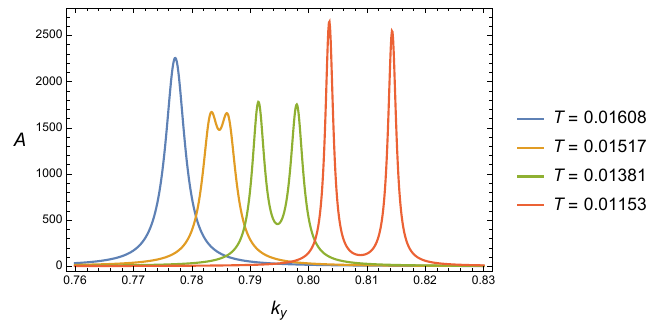
Figure 7 . Evolution of the band gap with temperature for the pure PDW case. We show the spectral density as a function of k y at the Brillouin boundary for (cid:12)xed ! = 10 (cid:0) 6 . From left to right, the four curves correspond to temperatures T=T c = 1, 0 : 94, 0 : 86, and 0 :